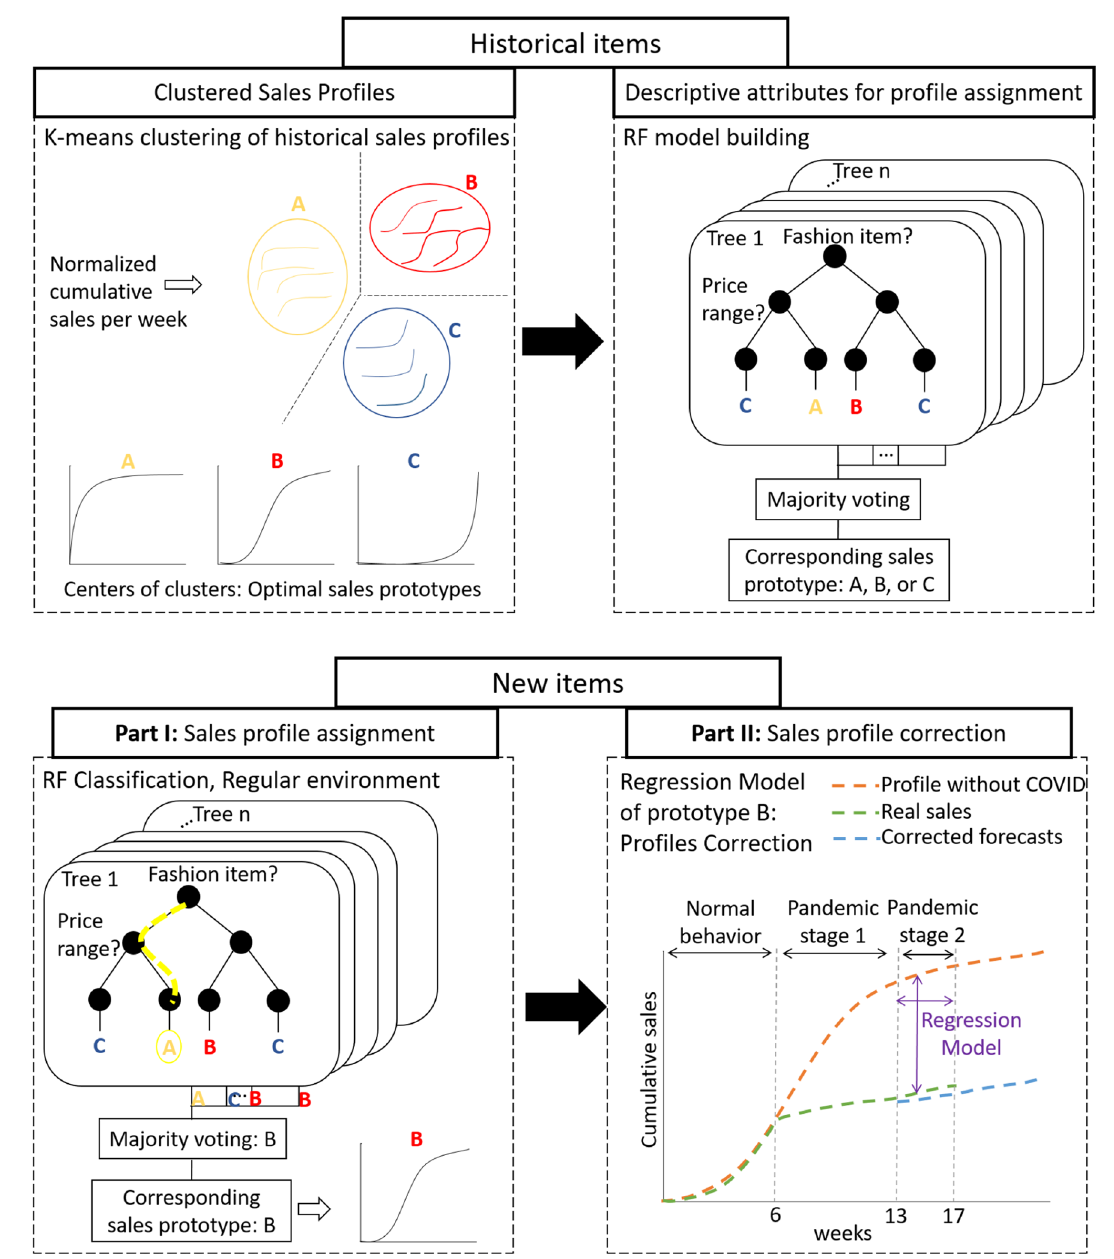
Fig. 3 Schematic representation of the proposed sales forecasting